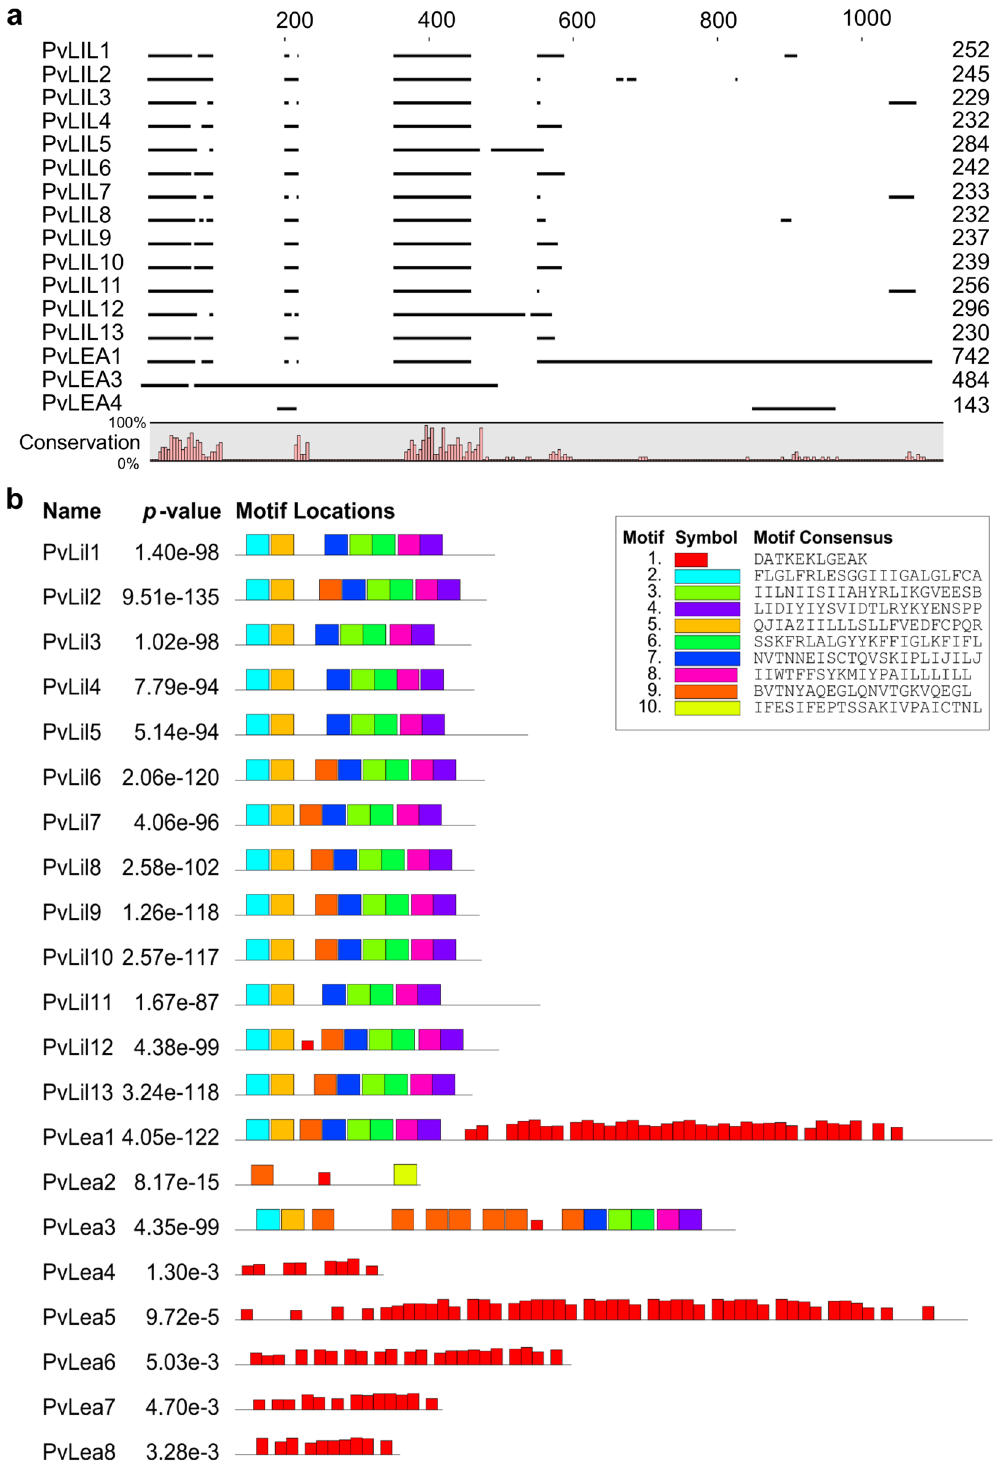
Figure 4. The similarity of PvLIL to PvLEA proteins and distribution of predicted motifs. ( a ) Multiple sequence alignment of 13 PvLIL and 3 PvLEA proteins. The similarity is restricted to N-terminus and C-terminus regions of PvLEA1 and PvLEA3, respectively. Alignment was performed in CLC Genomics Workbench 8.0 (QIAGEN, Denmark) with gap opening and extension penalties set to 10 and 0, respectively. ( b ) The amino acid motif composition of all PvLIL and PvLEA1–PvLEA8 proteins. The search for new amino acid motifs was performed on the MEME Suite server 20 using classic search mode with any number of motif repetitions for all sequences of PvLIL and PvLEA proteins. We removed PvLEA9 ‒ PvLEA27 from the bottom of the image for brevity. Maximum number of different motifs and maximum motif widths were set to 10 and 22, respectively. Found motifs are depicted as coloured blocks, whose height corresponds to their p value. Names of proteins and combined p value of all motifs for each protein sequence are given on the left. Removed proteins PvLEA9–PvLEA27 have one to four motifs of type #1 each with combined p values from 3.96e−22 to 1.19e−1, except for the PvLEA22 protein with no motif type #1